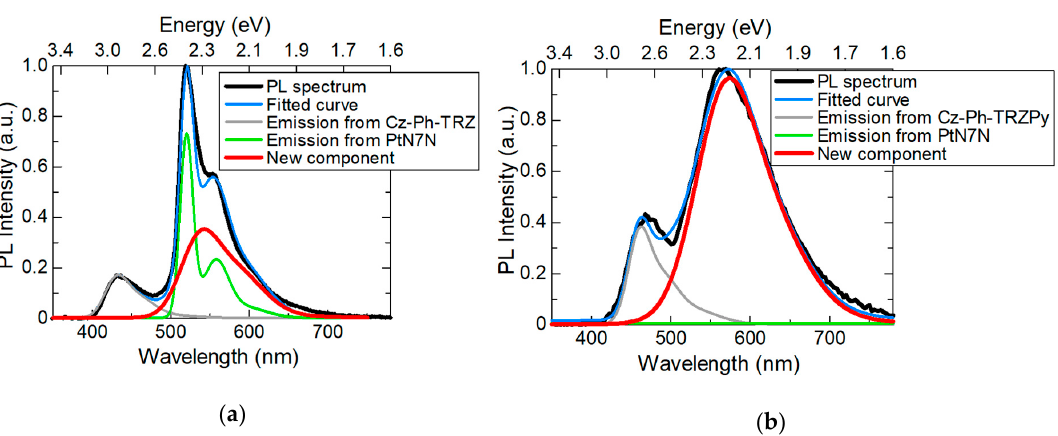
Figure 6. Deconvolution of the peaks in the PL spectra for the ( a ) PtN7N-doped Cz–Ph–TRZ film and ( b ) PtN7N-doped Cz–Ph–TRZPy film.